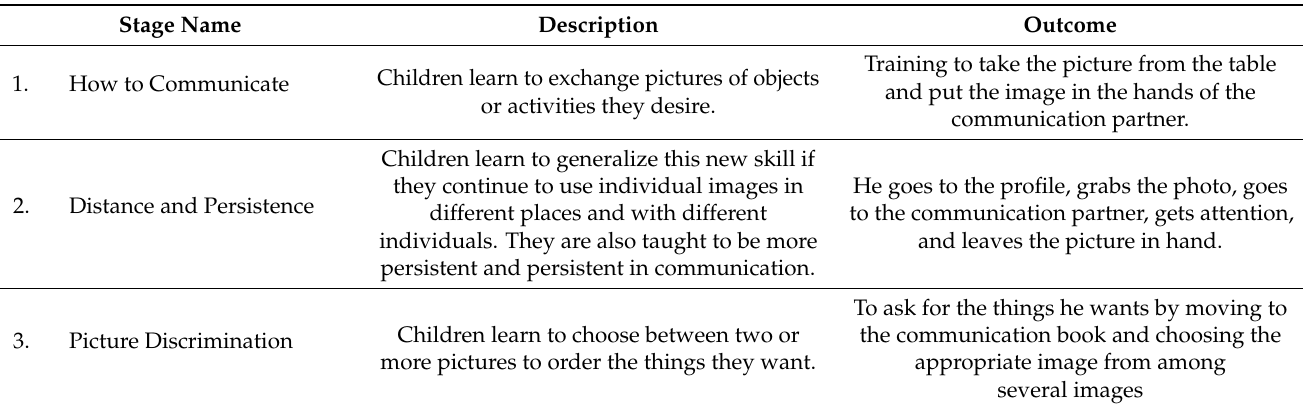
Table 3. Stages of